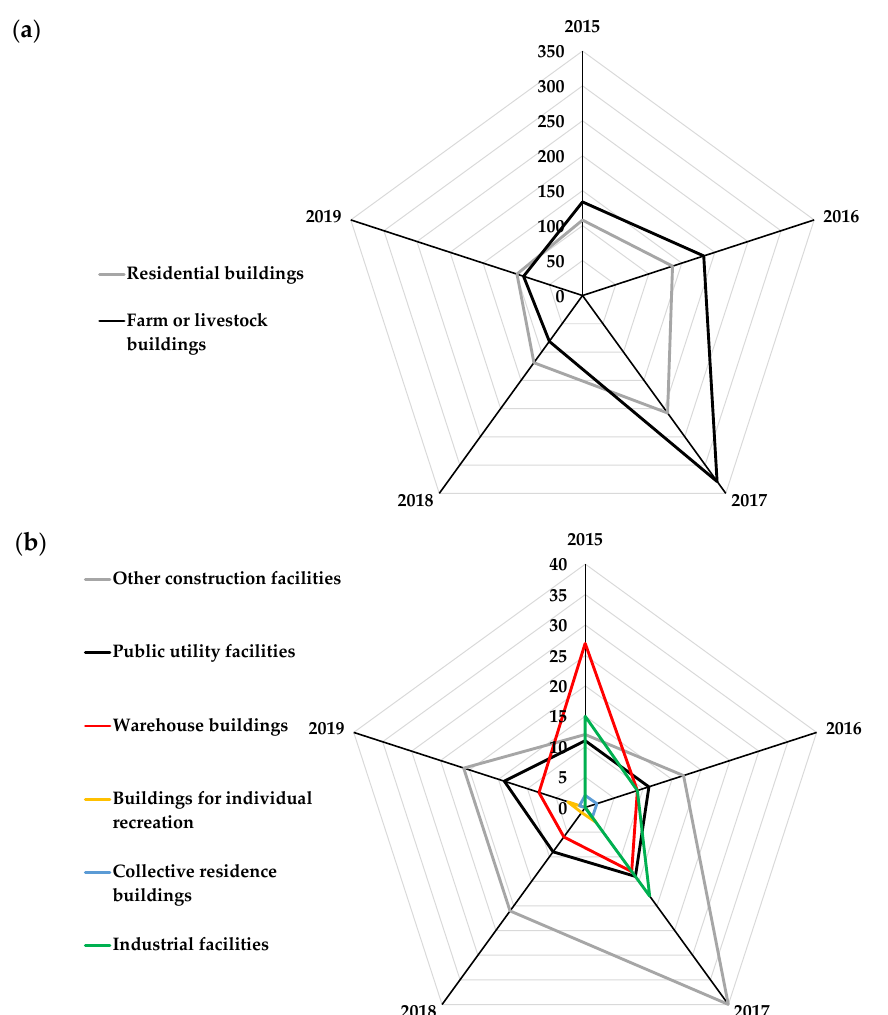
Figure 5. Analysis of the structural failures by type of facility in which the failure occurred ( a ) part 1; ( b ) part 2 (own study).